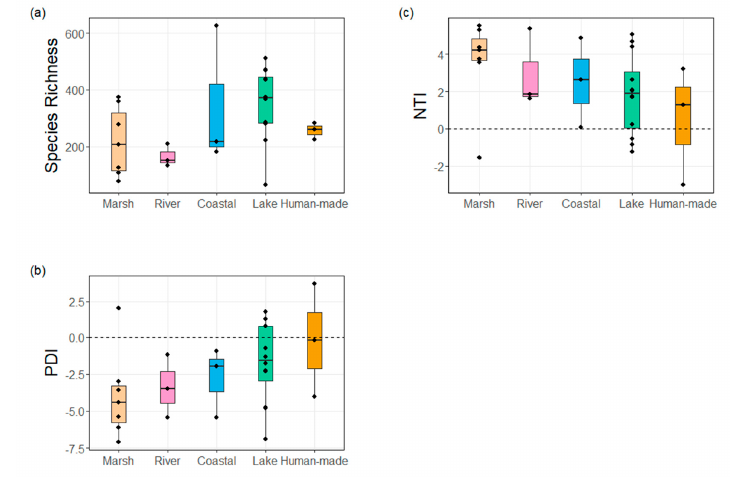
Figure 3. Species richness and phylogenetic diversity indices of wetland types.